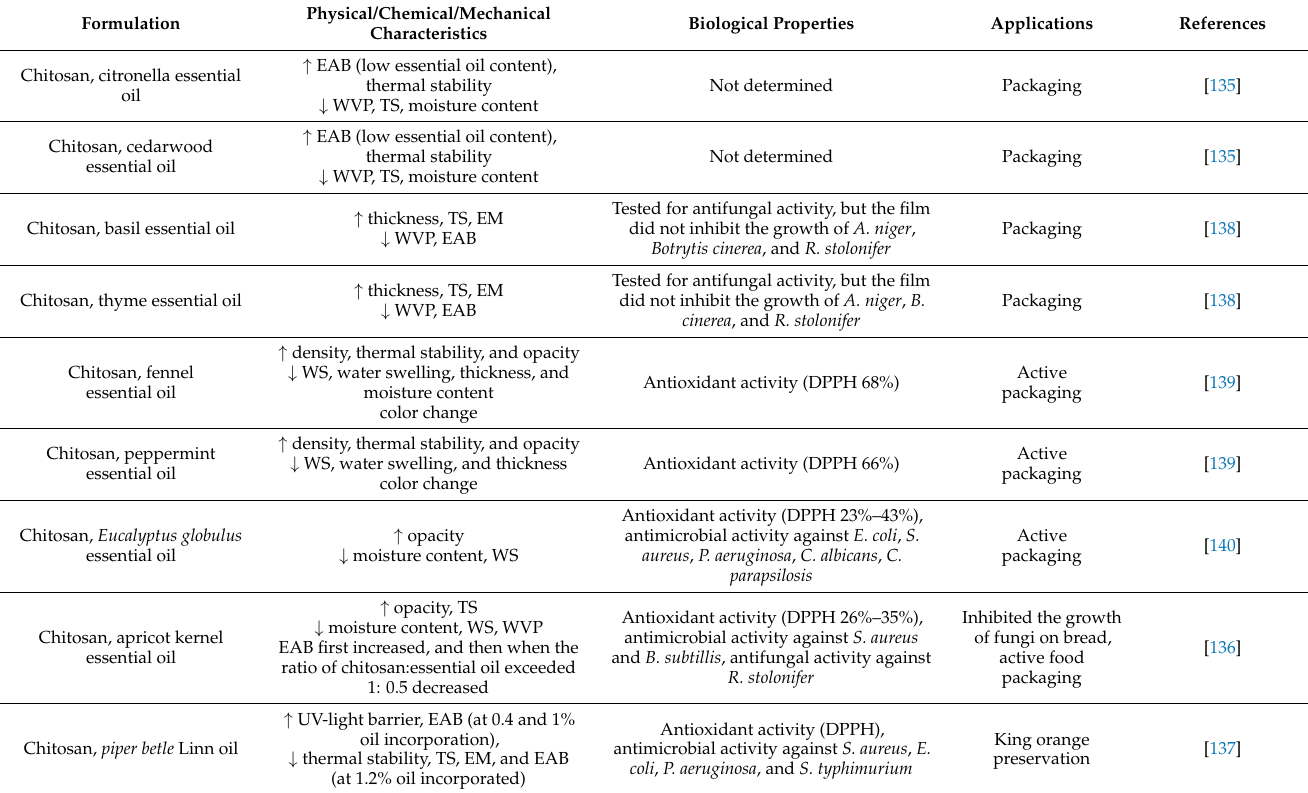
Table 6. The characteristics of chitosan–essential oil